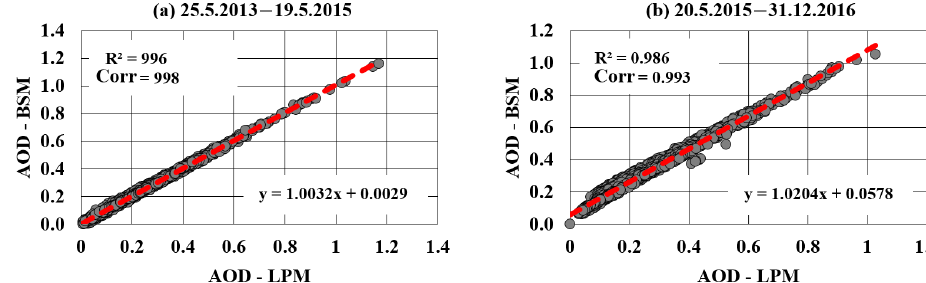
Figure 6. Comparison of AOD values for the wavelength of 320nm obtained by means of the LPM and BSM.